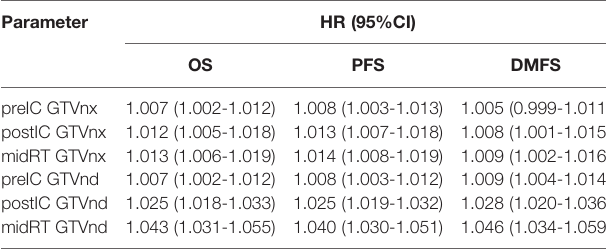
TABLE 1 | Univariate Cox analysis of volumetric parameters in different